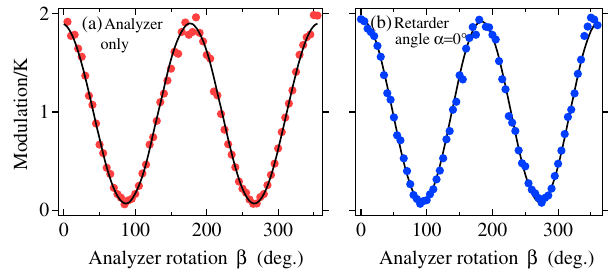
FIG. 12. Analyzer scan (markers) and fitting curves (solid line) for the linear horizontal polarized state. (a) Linear horizontal state measured with the analyzer only. In this case, the fitting function is given by I ¼ K ½ 1 þ P cos 2 ð β − δ Þ(cid:2) , where P is the degree lin lin of linear polarization (measured at 92%) and δ is a parameter that allows a fine adjustment of the position of the maxima. (b) Same polarization but measured with the complete polarimeter (ana- lyzer and phase retarder) by scanning the analyzer in a 0° – 360° range with a step of 5°. The fitting function in this case is given by Eq. (2), and the results are reported in Table VII.